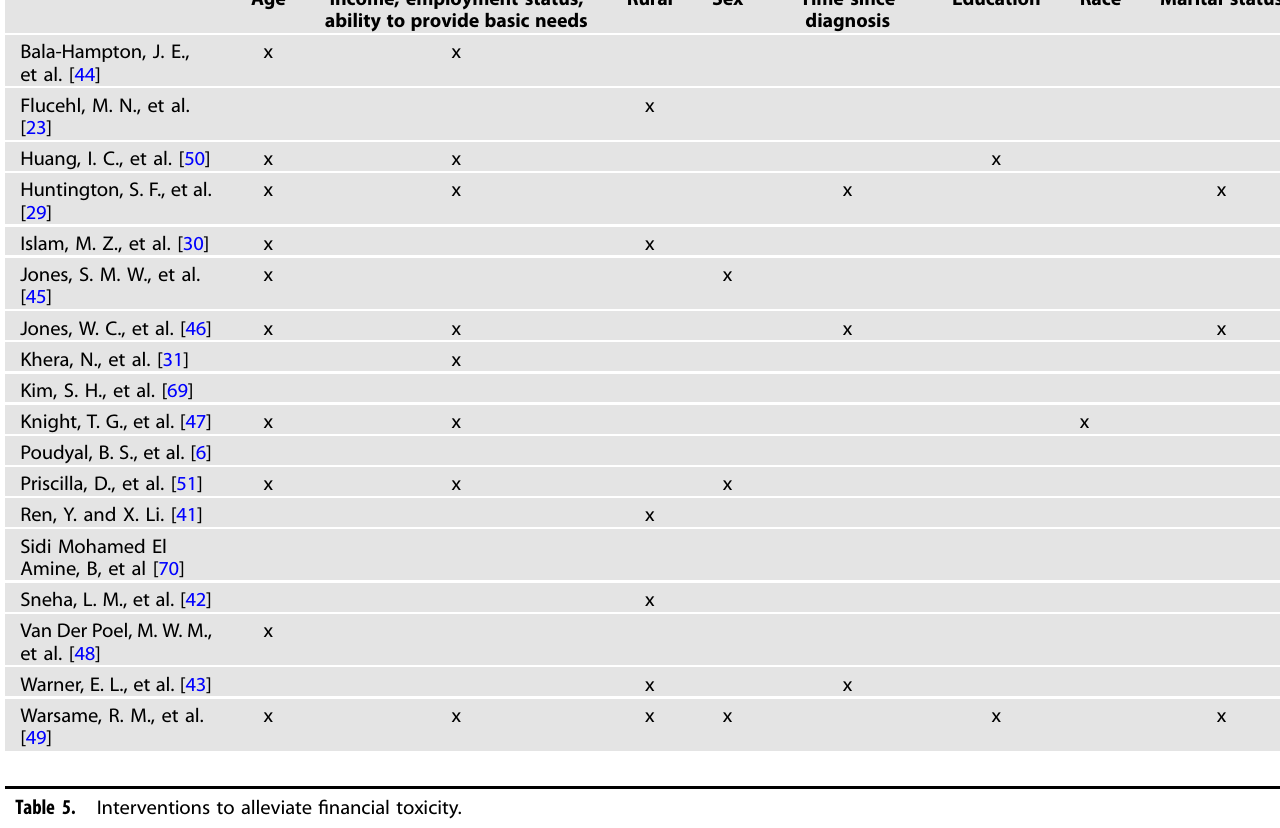
Table 4. Risk factors for incurring fi nancial